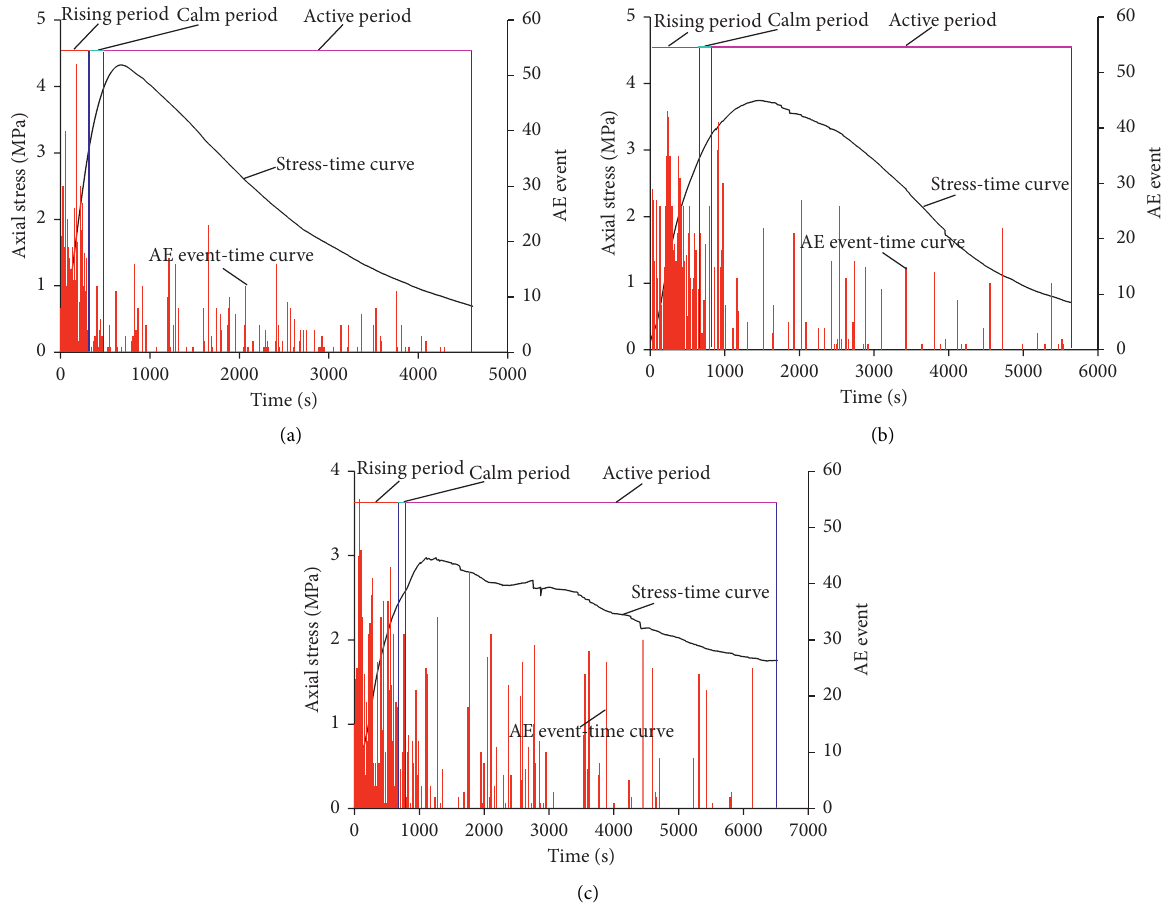
Figure 9: AE characteristics of composite samples. (a) A-3 composite sample. (b) B-1 composite sample. (c) C-3 composite sample.